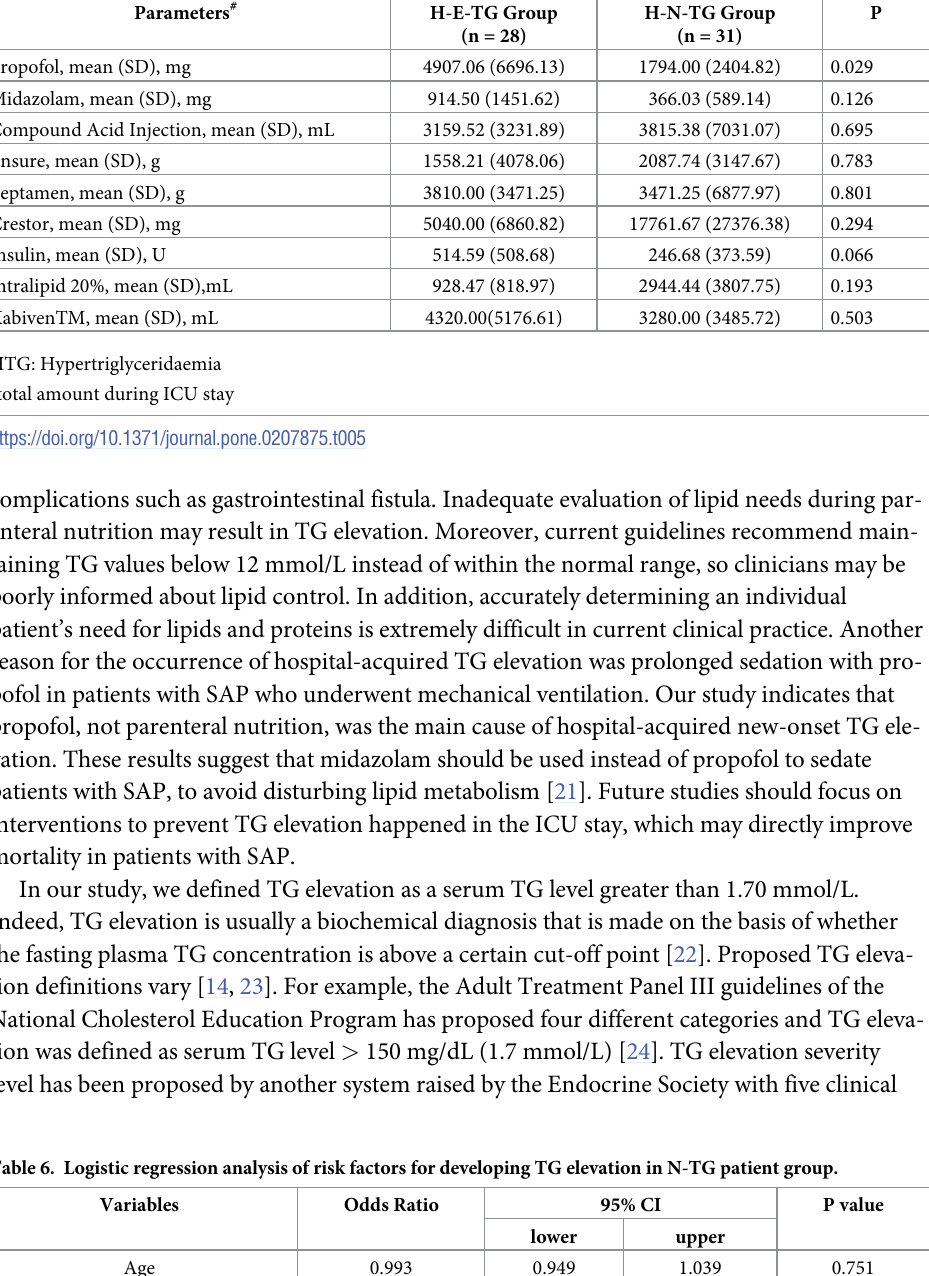
Table 5. Treatments which may have influenced Serum triglyceride level during ICU stay in SAP patient cohort with normal TG level at admission. Parameters #